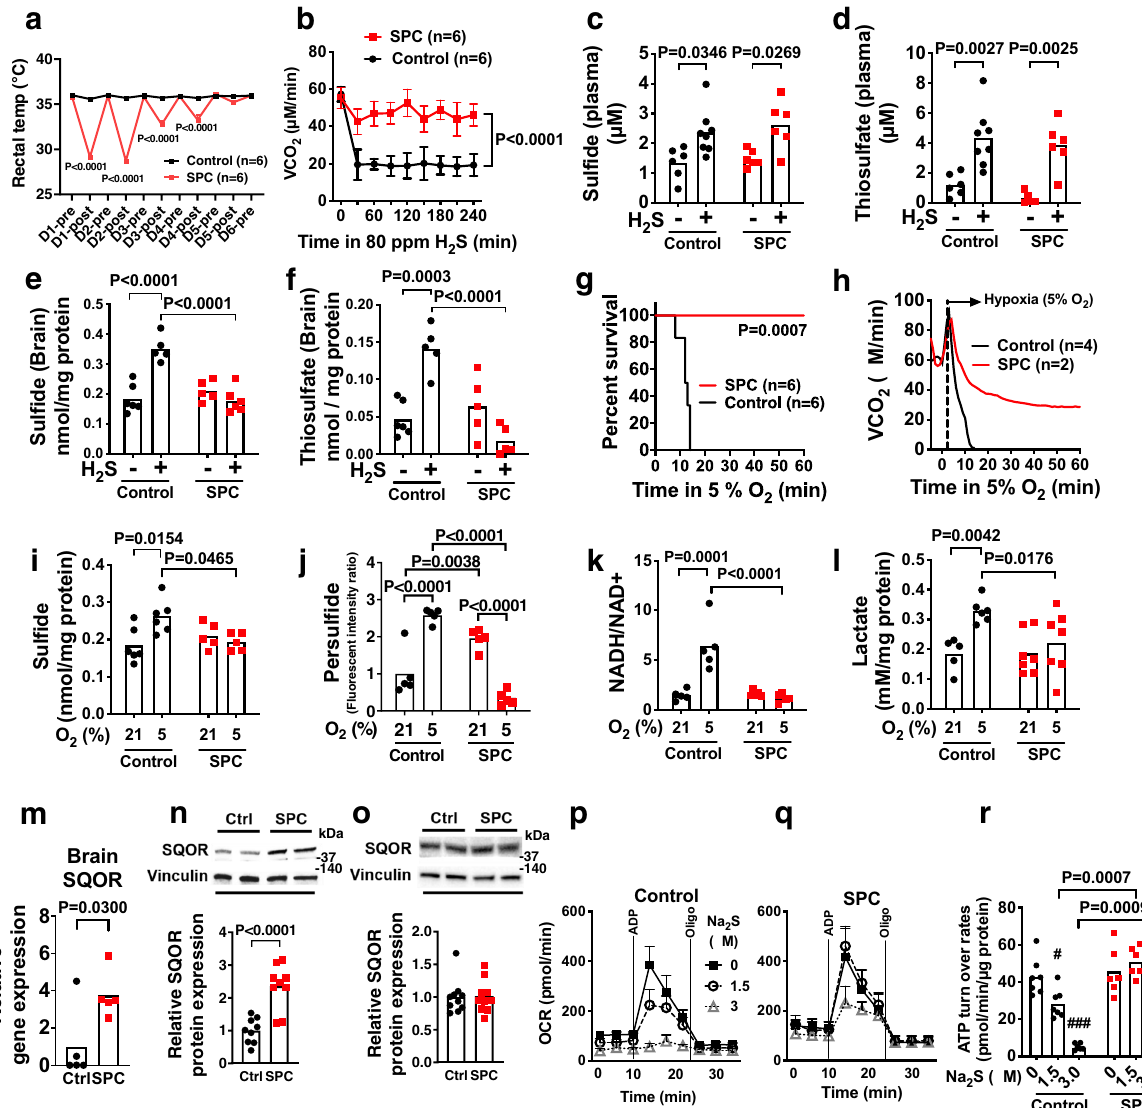
Fig. 1 Effects of sul fi de pre-conditioning on sul fi de metabolism and hypoxia tolerance in mice. a Body temperature of control and sul fi de pre-conditioned (SPC) mice. “ Pre ” and “ post ” time points depict mice before and after breathing air (control) or H 2 S at 80 ppm for 4 h, respectively, from day 1 (D1) to day 6 (D6). b Whole-body CO 2 production rate (VCO 2 ) of SPC and control mice during H 2 S breathing on the 6th day after starting SPC or control air breathing. Concentration of c sul fi de (from left to right, n = 6, 8, 6, 6) and d thiosulfate ( n = 6, 8, 6, 6) in plasma and concentrations of e sul fi de ( n = 6 each) and f thiosulfate ( n = 6 each) in the brain of SPC and control mice during H 2 S or air breathing on the 6th day. g Survival rate and h VCO 2 of mice breathing 5% O 2 on the 6th day in control or SPC mice. Brain levels of i sul fi de ( n = 6, 6, 5, 5), j persul fi de ( n = 5 each), k NADH/NAD + ratio ( n = 5 each), and l lactate levels ( n = 5, 6, 7, 7) in control and SPC mice breathing at FiO 2 = 21% or 5% on the 6th day. m Relative mRNA levels of SQOR in the brain of SPC and control mice (normalized as control = 1). n = 5 each. SQOR protein levels in n the brain tissue extracts ( n = 9 each) and in o the heart ( n = 10 each) from control and SPC mice. Oxygen consumption rate (OCR) of isolated brain mitochondria from p control ( n = 7) and q SPC ( n = 6) mice with or without incubation with sul fi de (Na 2 S, 0, 1.5, 3.0 µ M) and r calculated ATP turnover rates ( n = 7, 7, 7, 6, 6, 6). Data are presented as mean ± SEM or mean and individual values. # P < 0.05, ## P < 0.01, ### P < 0.001 vs Na 2 S at 0 µ M of respective group. Two-way ANOVA followed by Sidak ’ s or Tukey ’ s correction for post-hoc comparisons were performed for a – f , i – l , and r . Survival rates were estimated using the Kaplan – Meier method and a log-rank test was used to compare the survival curves between groups in g . A two-tailed unpaired t -test was performed for m – o